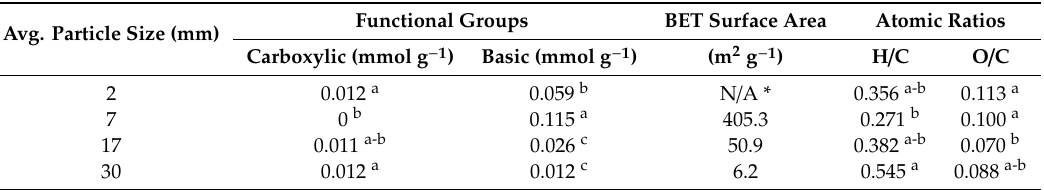
Table 4. Chemical properties of biochar from wood chips produced with varying particle sizes. BET: